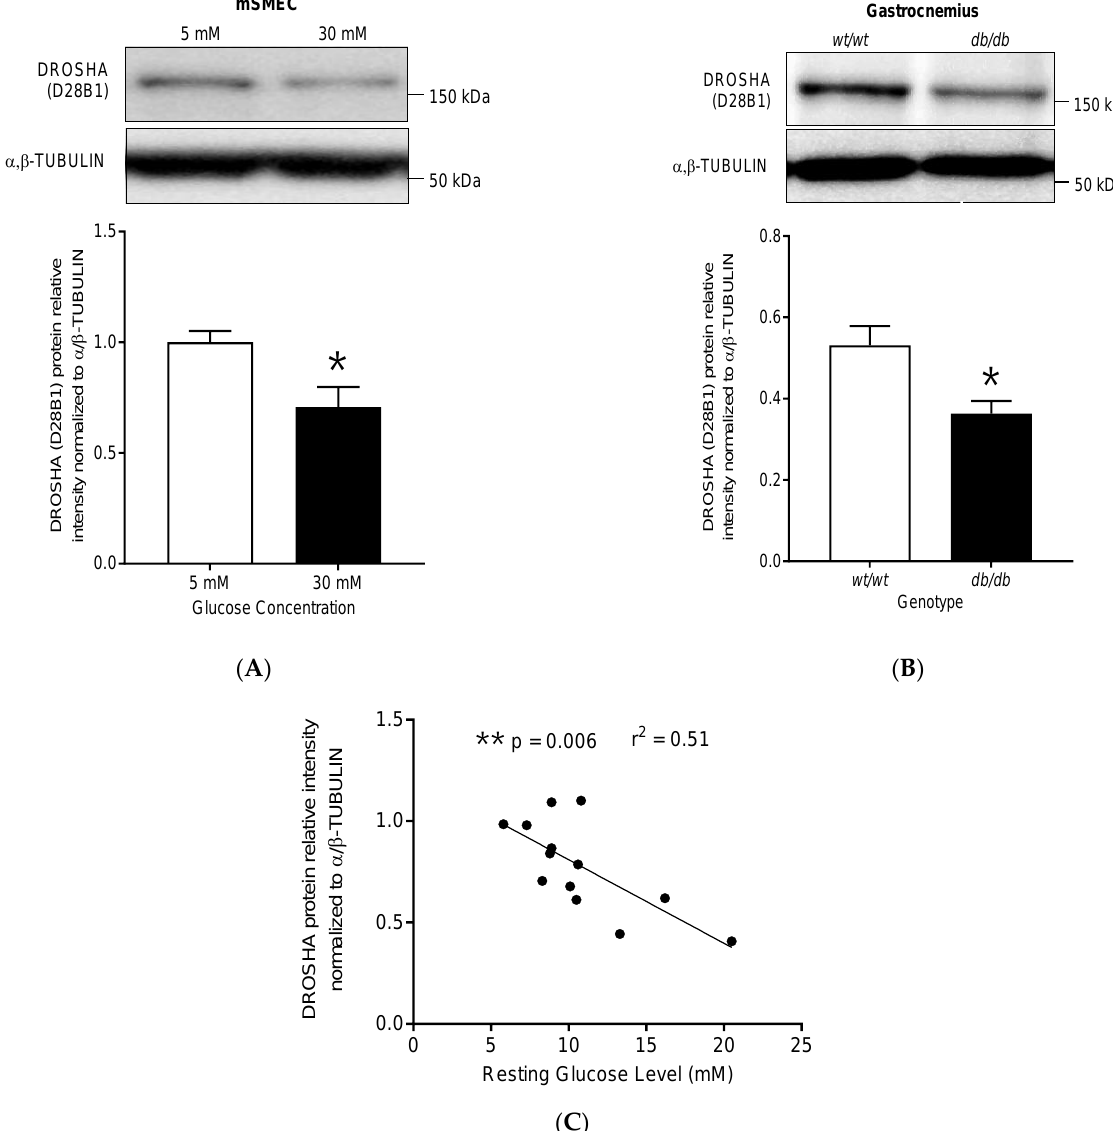
Figure 5. High glucose conditions decrease DROSHA protein expression in mouse skeletal muscle tissue. ( A ) Immunoblot of DROSHA expression in mouse primary endothelial cells isolated from skeletal muscle tissue (mSMECs) following 24 H treatment with high (30 mM) or low (5 mM) glucose concentrations. α/β-TUBULIN was used as a loading control. High glucose concentration (30 mM) decreased DROSHA protein expression (data are means ± SEM, n = 6, * p < 0.05). ( B ) Immunoblot of DROSHA expression in gastrocnemius muscles from wild-type ( wt/wt ) and leptin receptor deficient ( db/db ) mice (data are means ± SEM, n = 4–7, p = 0.034). The db/db mice expressed significantly less DROSHA protein compared to their wild-type littermates (data are means ± SEM, n = 4–7, * p < 0.05). ( C ) Correlation analysis between DROSHA protein expression and resting blood glucose levels in gastrocnemius muscles from 4-week-old mice, including 2 wt/wt , 2 db/db and 9 db/wt mice. Resting blood glucose is negatively correlated with DROSHA protein expression in mice skeletal muscle ( n = 13, ** p = 0.006).